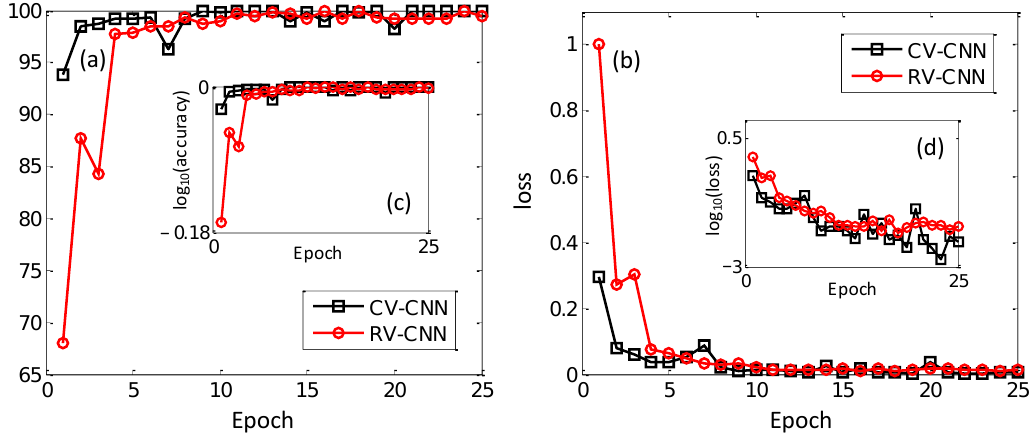
Figure 5. Training results of CV-CNN and RV-CNN on training set. ( a ) Training accuracy, ( b ) Training loss, ( c ) Training accuracy with logarithmic scale, ( d ) Training loss with logarithmic scale.